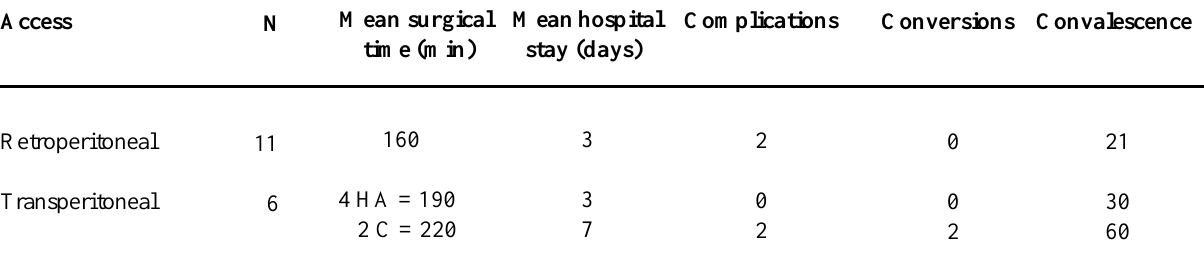
HA = hand assistance, C = conversion to open